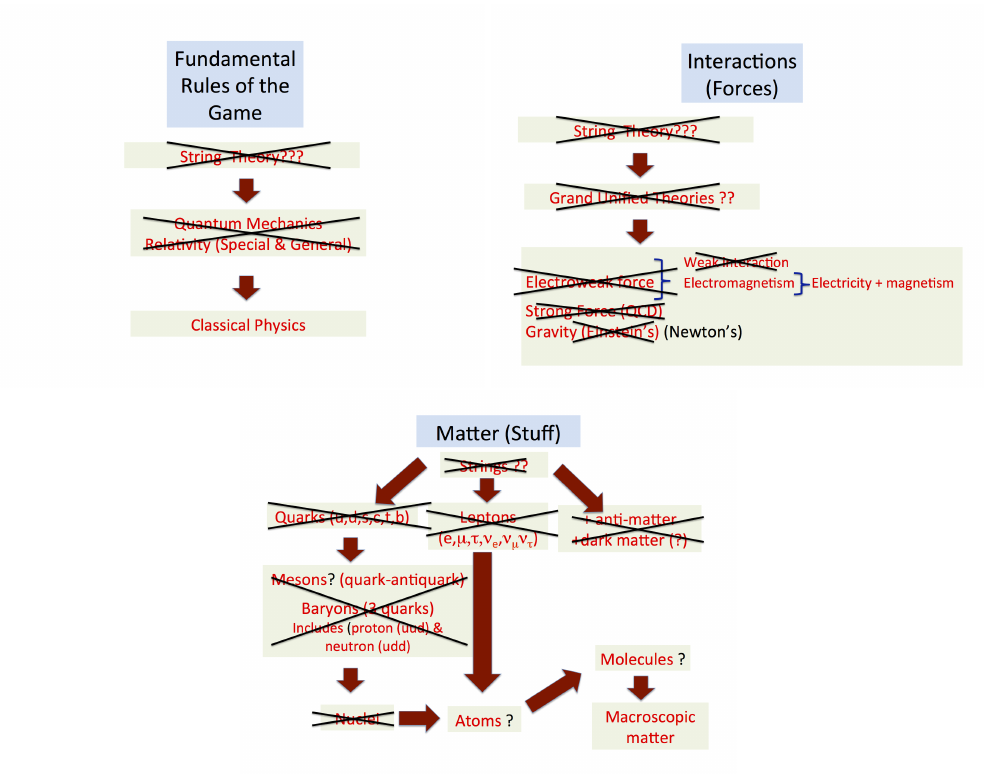
Figure 2: A highly incomplete and cartoon-like overview of our current understand- ing of fundamental